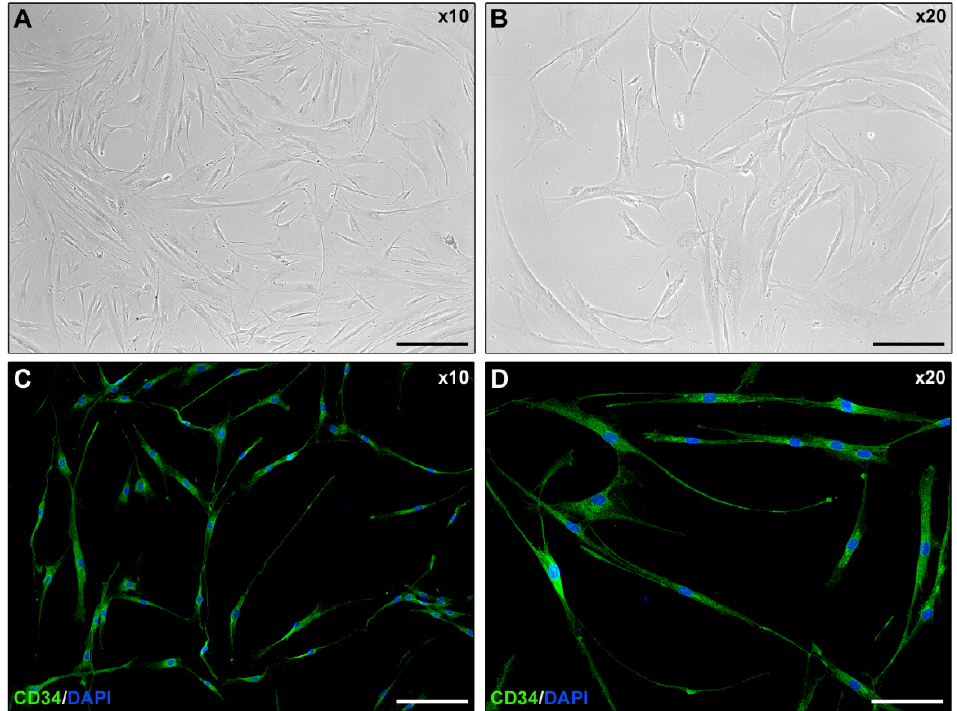
Figure 1. Morphological and immunophenotypical features of explanted and in vitro cultured nor- mal human corneal keratocytes. Representative phase-contrast ( A , B ) and CD34 immunofluorescence ( C , D ) photomicrographs of keratocytes at first passage in culture. Original magnification: ×10 ( A , C ), ×20 ( B , D ). Scale bar: 200 μ m ( A , C ), 100 μ m ( B , D ).